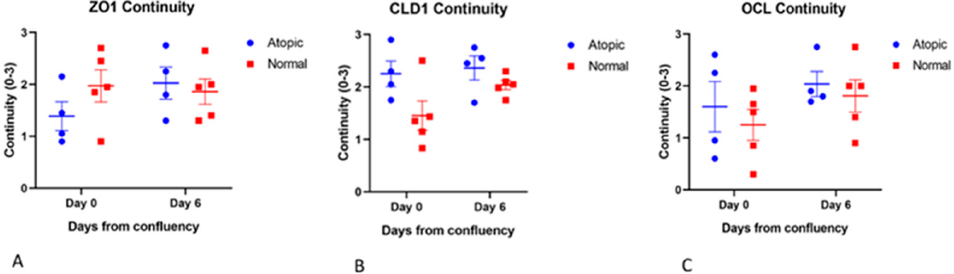
Figure 4. Average of subjective scoring done by four observers on five pictures of each antibody for each chamber ( A – C ). Observers were not aware of the source of the cells scored. No significant differences were found for any of the TJ proteins between groups or overtime in terms of continuity. For this scoring, four atopic cell cultures and 5 normal cells cultures were used.